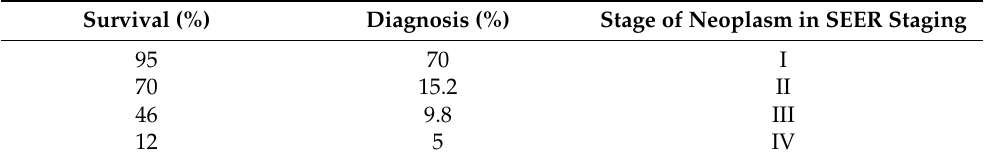
Table 1. Cutaneous melanoma; stage at diagnosis and 5-year survival. Survival (%) Diagnosis (%) Stage of Neoplasm in SEER Staging